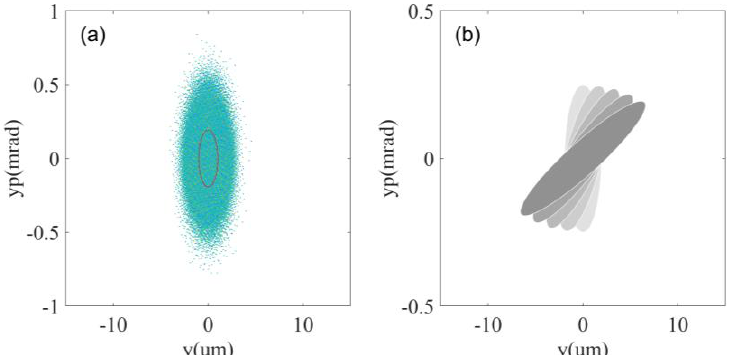
Figure 1. Transverse phase space distribution of electron beam: ( a ) definition of emittance, area (red line) = emittance × π ; ( b ) phase space distribution of electron beam with different phase. Beam density remains constant in the phase space according to the Liouville